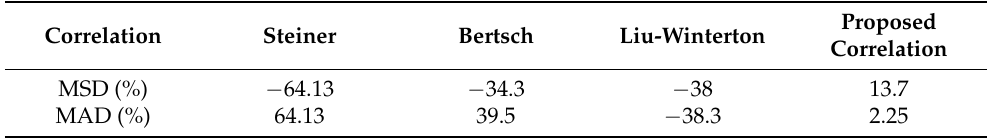
Table 5. Evaluation of heat transfer coefficient